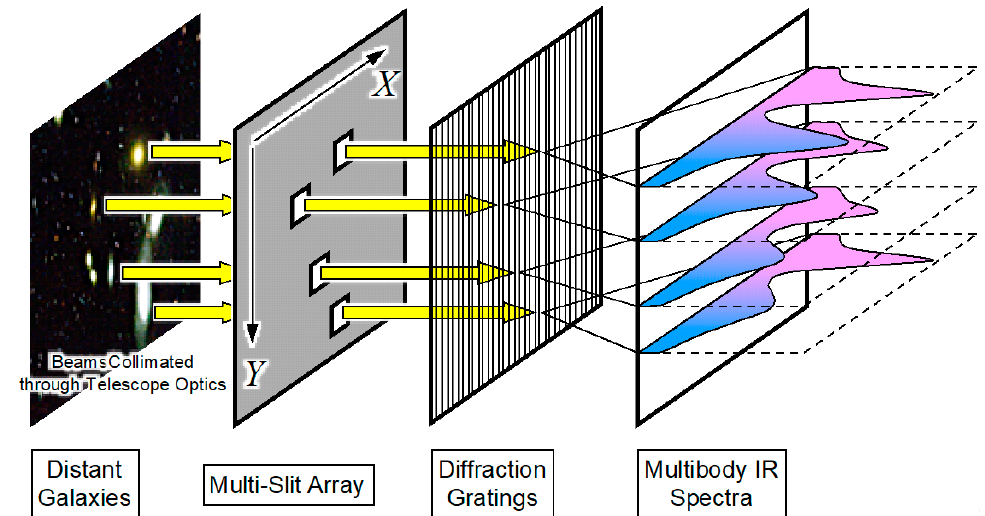
Figure 1. Schematic illustration of multi-object spectroscopy (MOS) for deep galactic astronomy. The starlights from distant galaxies are spatially filtered by the multi-slit array plate, and guided to the gratings to project multiple spectra on the infrared imaging device for simultaneous